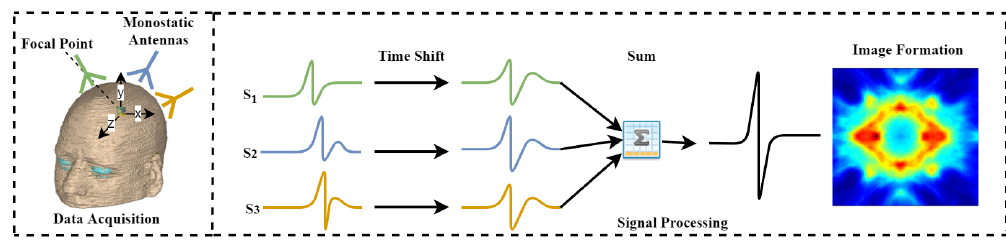
Figure 1. Microwave imaging via space-time (MIST) beam-forming process for a focal point. S 1 , S 2 , and S 3 are backscattered signal. These signals are first time shifted and then summed together to find the energy for the specified focal